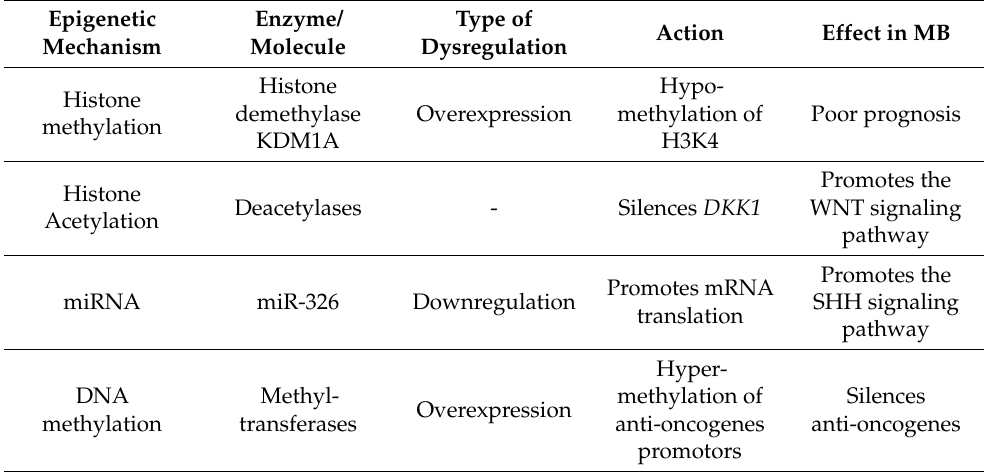
Table 4. Summary of presented epigenetic mechanisms dysregulations in medulloblastoma.